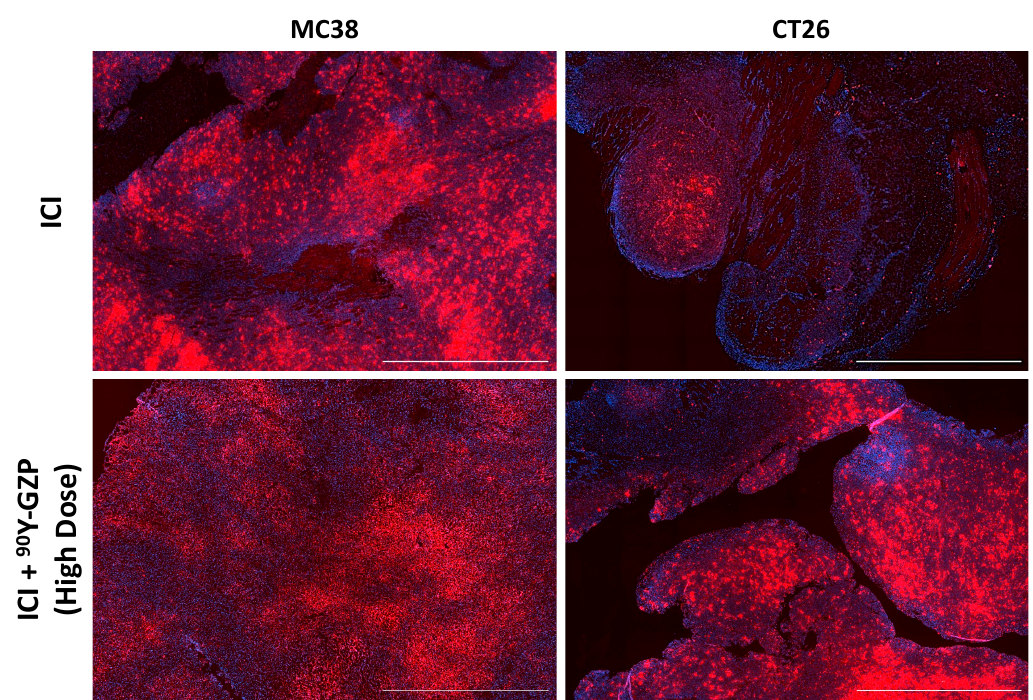
Figure 5. Immunofluorescence staining against granzyme B (red) of tumor samples after ICI therapy only and ICI + 90 Y-GZP (high dose) demonstrating high levels of granzyme B presence within the tissue. Nuclei are stained with DAPI (blue). Scale bar = 200 µM.